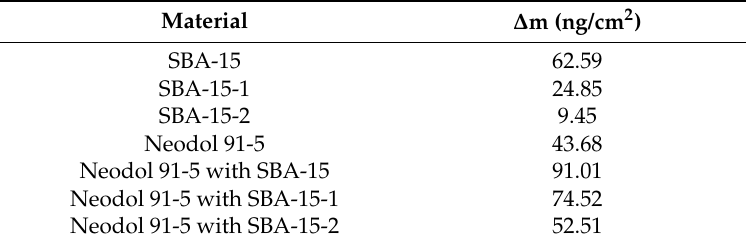
Table 2. Adsorbed mass ( ∆ m) of the different materials onto SiO 2 -Ti